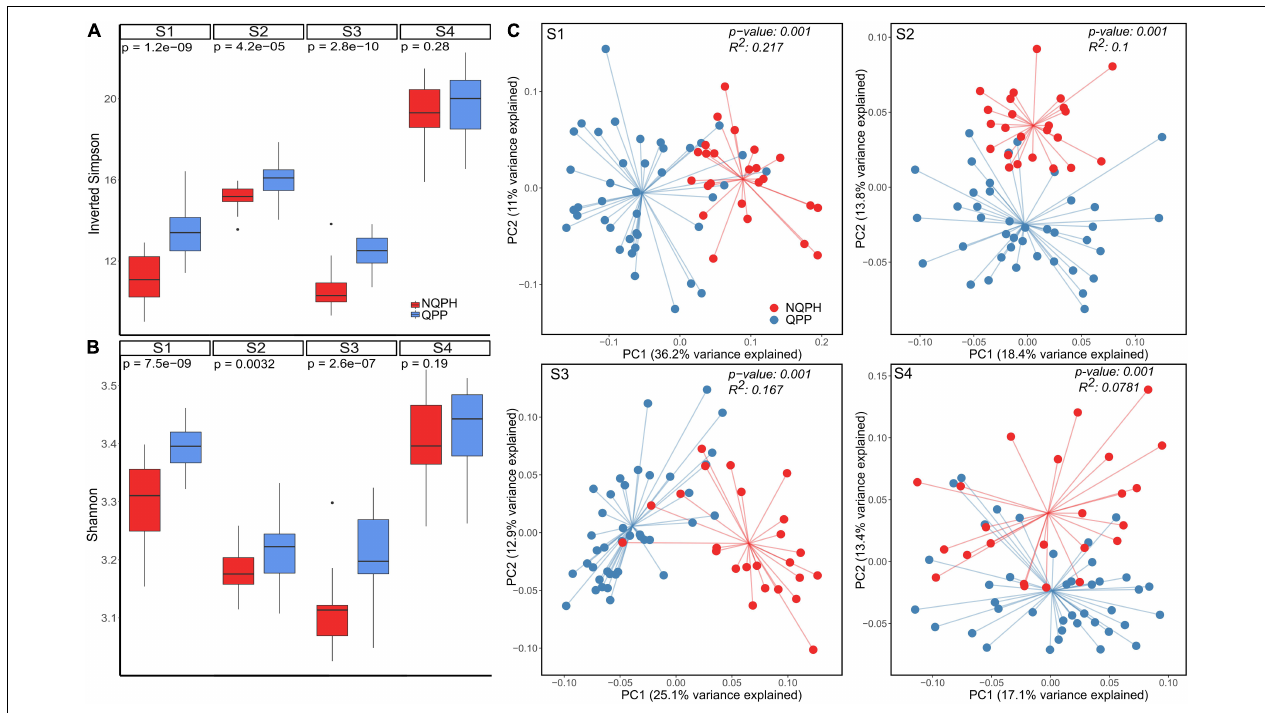
FIGURE 1 | (A) Diversity reported as Inverted Simpson and (B) Shannon metrics of α -diversity for global differences between the microbial response to quality-protein popcorn (QPP) and non-quality-protein parental hybrid (NQPH); p -values were calculated by Wilcoxon test. (C) Jaccard index of β -diversity coupled with PCoA ordination shows total differences between microbiome response to QPP and